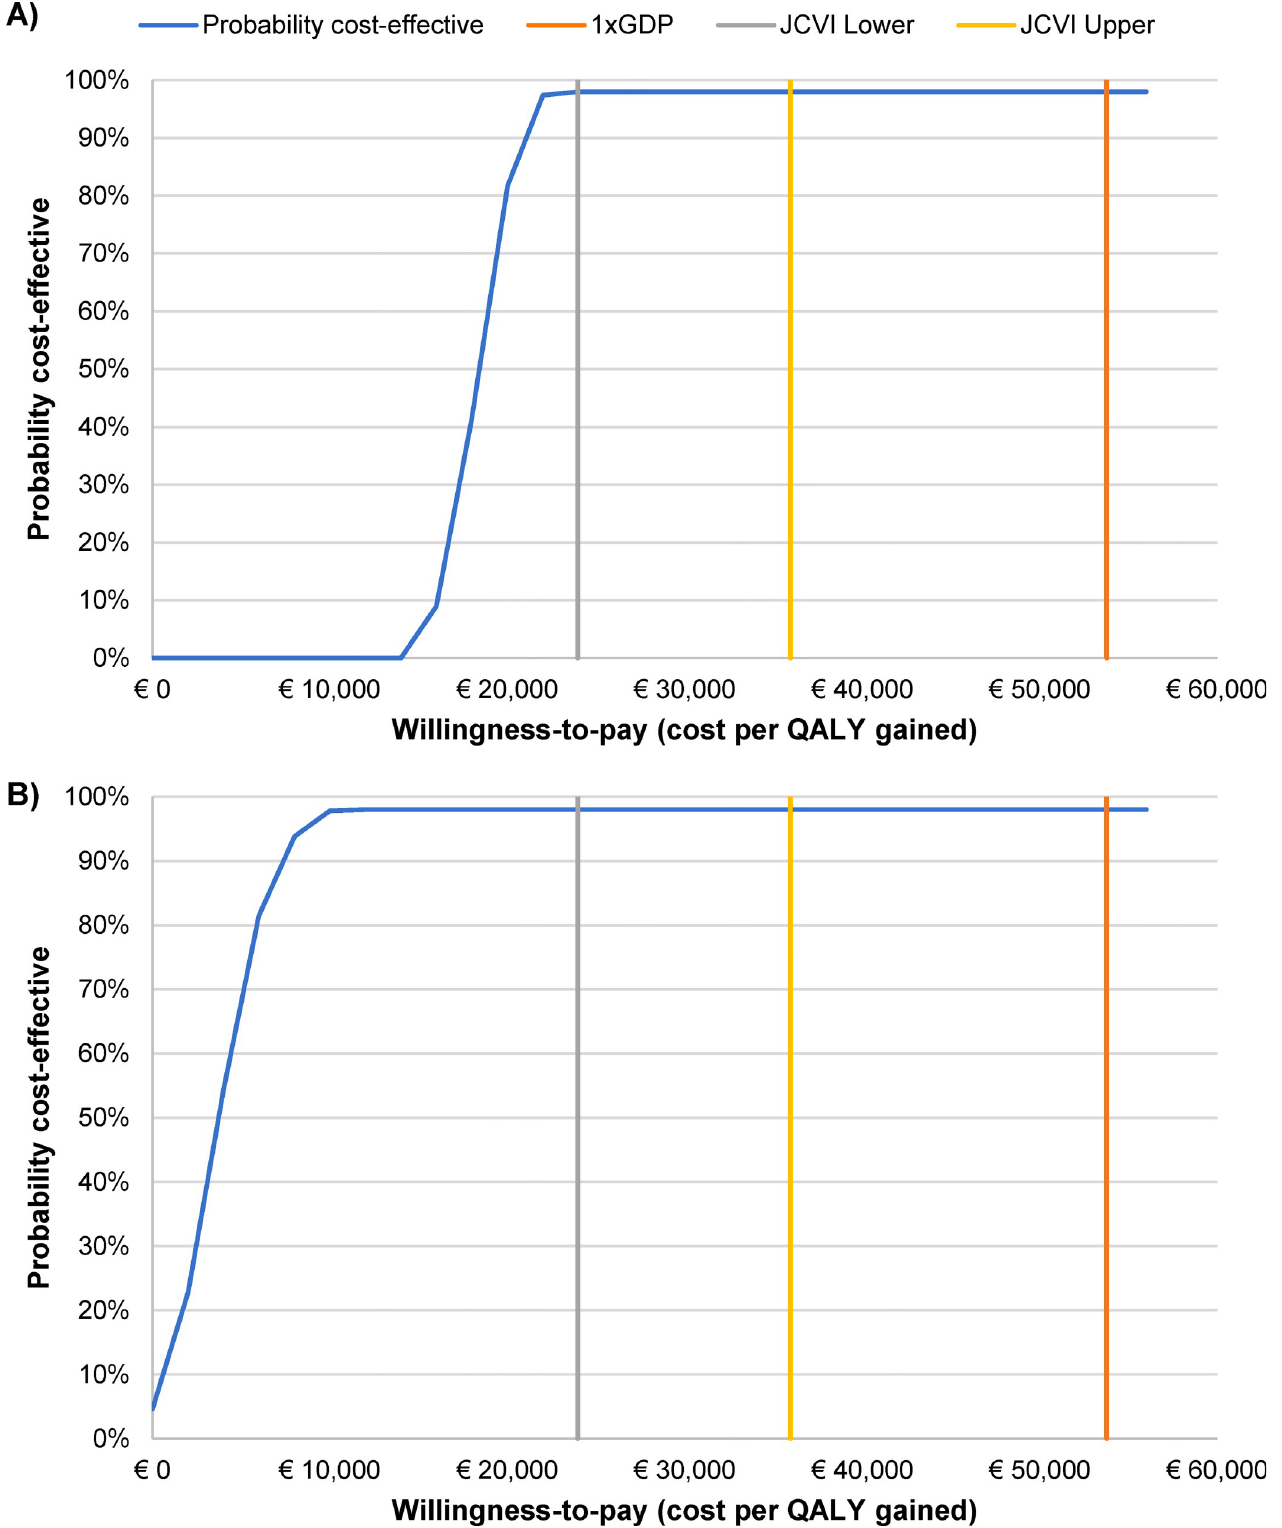
Fig 5. Cost-effectiveness acceptability curve for vaccination Strategy E versus no vaccination, from the A) payer and B) societal perspectives. Strategy E : V-MSD (15 months) + MMRV-MSD (48 months). Costs in Euros.